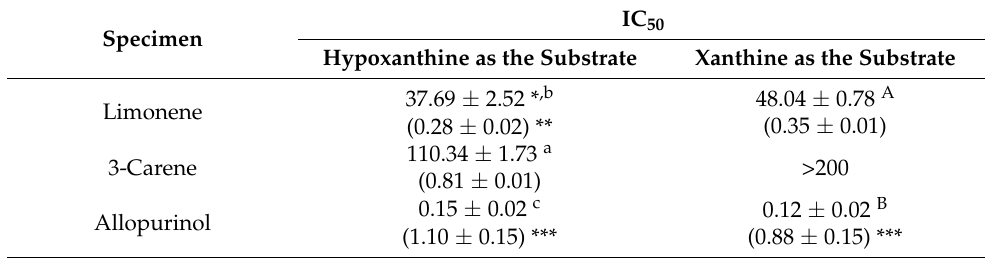
Table 4. IC 50 values of main compounds of fraction E1 against xanthine